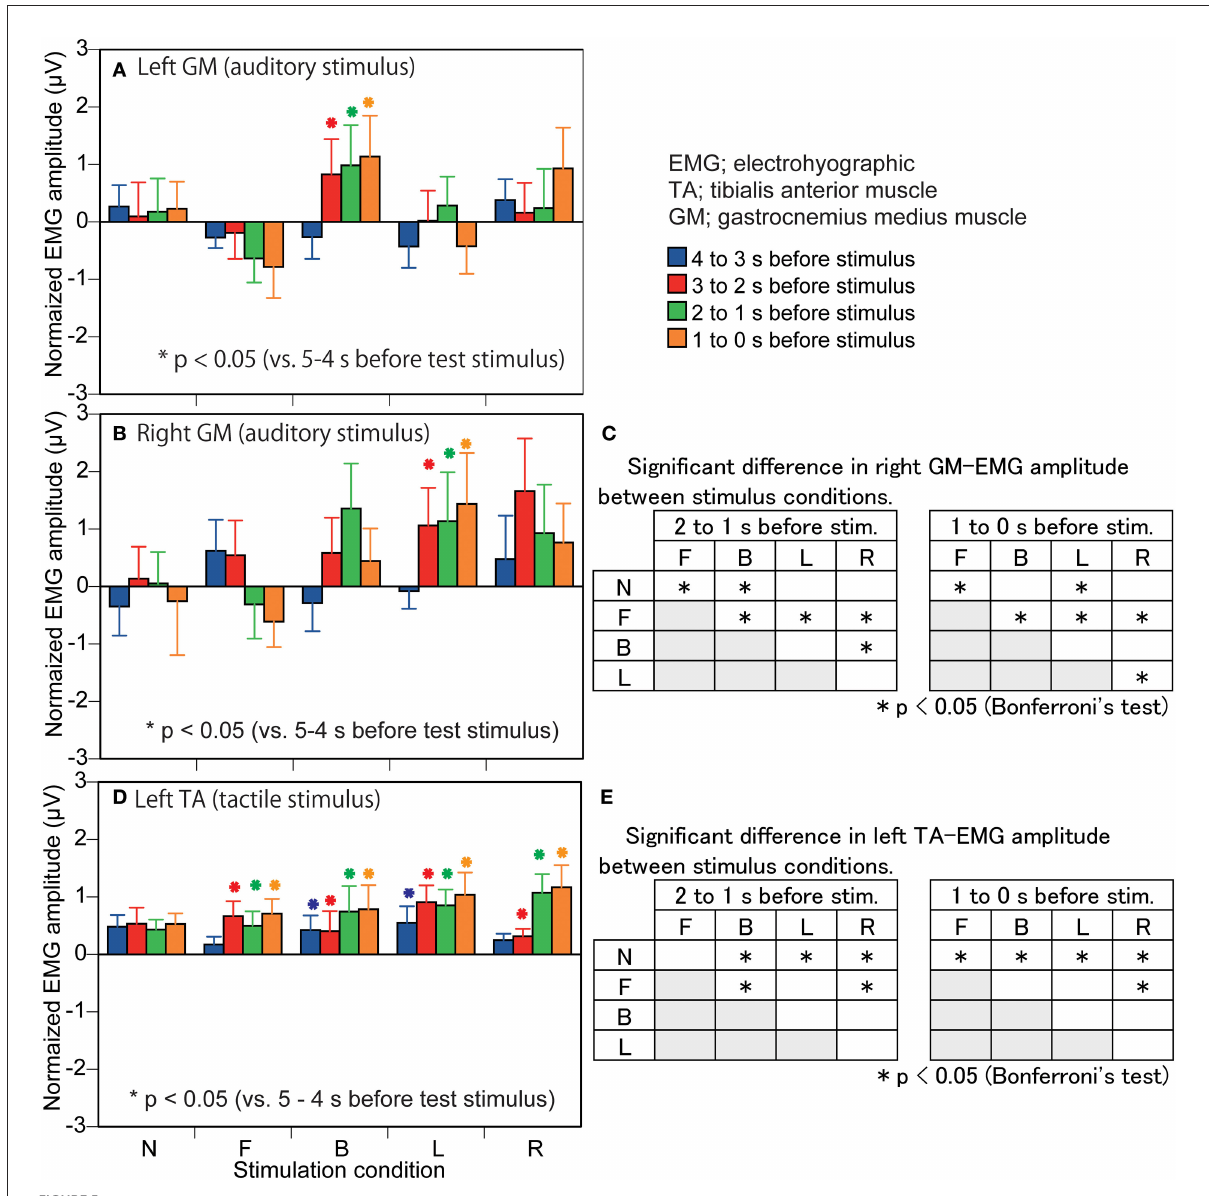
FIGURE5 Effect of predicting the stimulus site on the EMG amplitude in the muscles in which a significant interaction between the main effects is revealed. The data are normalized by subtracting the average value at 1–0s before the onset of the visual cue (5–4s before the stimulus) from the values averaged at each 1s in the time window between 4 and 0s before the stimulus. Bars indicate the mean, and error bars indicate standard errors of the mean in the left panels (A,B,D) . Asterisks indicate significant differences from mean amplitude at the time 5–4s before the stimulus (1–0s before the visual cue) in the same condition in the left panels (A,B,D) . The results of Bonferroni test for the right GM amplitude in the auditory trial block are shown in panel (C) and those for the left TA in the tactile stimulus trial block are shown in panel (E) . N, trials with the cue predicting non-stimulation; F, trials with the cue predicting the stimulus to the forehead; B, trials with the cue predicting the stimulus to the back of the head; L, trials with the cue predicting the stimulus to the left side of the head; R, trials with the cue predicting the stimulus to the right side of the head. EMG,